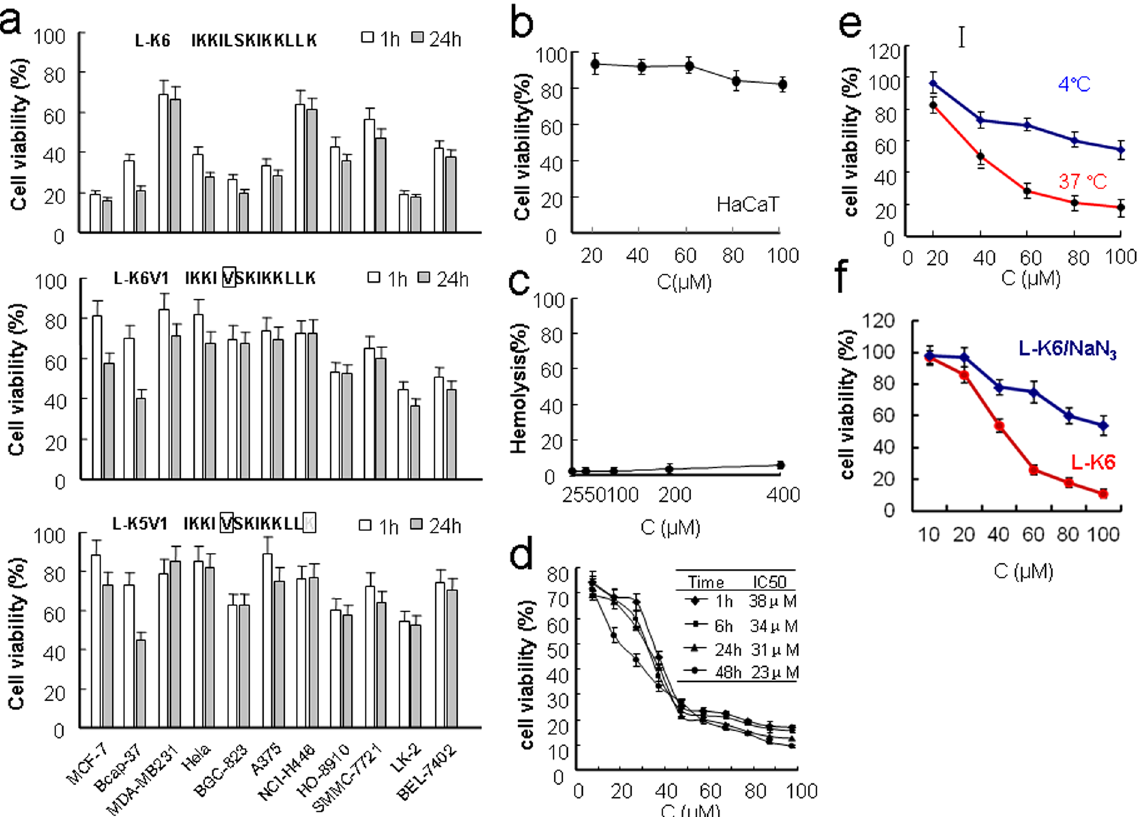
Figure 1. Cytotoxicity of lysine/leucine-rich peptides as assessed by MTT assay. L-K6 exerts much stronger cytotoxicity against various cancer cell lines than L-K6V1 and L-K5V1, with MCF-7 cells exhibiting the most sensitivity ( a ). In contrast, L-K6 exerts much less cytotoxicity against non-cancerous HaCaT cells ( b ). The hemolysis assay further supported the cancer-targeting property of L-K6 ( c ). Additionally, MTT assay indicated that L-K6 rapidly reduced the viability of MCF-7 cells in a dose- and time-dependent manner ( d ). Interestingly, our data also revealed that the cytotoxicity of L-K6 on the MCF-7 cells was thermo-sensitive ( e ) and energy- dependent ( f ). All experiments had been performed in triplicate. The data were expressed as mean ± Effects of endocytosis inhibitors on the uptake of L-K6 by MCF-7 cells. The data from MTT assay and confocal microscope observation suggested an energy-dependent manner of L-K6 cellular uptake. Therefore, by using various endocytosis inhibitors, we next investigated whether endocytic pathways were involved in the cellular uptake of L-K6 by MCF-7 cells. MCF-7 cells were treated with FITC-labeled L-K6 (10–50 μ M) in the presence or absence of various endocytosis inhibitors for one hour. The cellular uptake of peptides was deter- mined by using super-resolution microscopy, FACS analysis or microplate reader. As shown in Fig. 5 and Suppl Fig. S1a, methyl- β -cyclodextrin (M β -CD), a caveolae-mediated endocytosis inhibitor, reduced the cellular uptake of L-K6. Another macropinocytosis inhibitor, cytochalasin D (CyD), also significantly blocked the internaliza- tion of L-K6, as evidenced by an over 90% reduction of L-K6 at 10–30 μ M and an approximately 50% reduction at 50 μ M (Fig. 5 and Suppl Fig. S1a). In contrast, macropinocytosis inhibitor ethylisopropylamiloride (EIPA) decreased the cellular uptake of L-K6 only at 50 μ M (Suppl Fig. S1a). Additionally, chlorpromazine (CPZ), a inhibitor of clathrin-mediated endocytosis, showed no ameliorating potential against the internalization of L-K6 into MCF-7 cells (Suppl Fig. S1a). All these data suggested that a clathrin-independent macropinocytosis pathway was involved in the cellular uptake of L-K6 by MCF-7 cells. The microplate reader assay revealed similar impacts of endocytosis inhibitors on the cellular uptake of L-K6 (Suppl Fig. S1b, left panel). Moreover, the microplate reader assay also indicated that the cellular uptake of L-K6 was blocked by low temperature (4 °C) (Suppl Fig. S1b, right panel), suggesting a thermo-sensitive and energy-dependent fashion of L-K6 cellular uptake. To further explore the impacts of various endocytosis inhibitors on L-K6-induced cytotoxicity, the MCF-7 cells were treated with L-K6 in the presence of endocytosis inhibitors M β -CD, CyD, EIPA or CPZ for one hour. The cellular viability was determined by using MTT assay. The data clearly revealed that endocytosis inhibitors, with the exception of CPZ, partially ameliorated the cytotoxicity of L-K6 against the MCF-7 cells (Suppl Fig. S1c), as evidenced by increased IC 50 values (Suppl Fig. S1c,d).